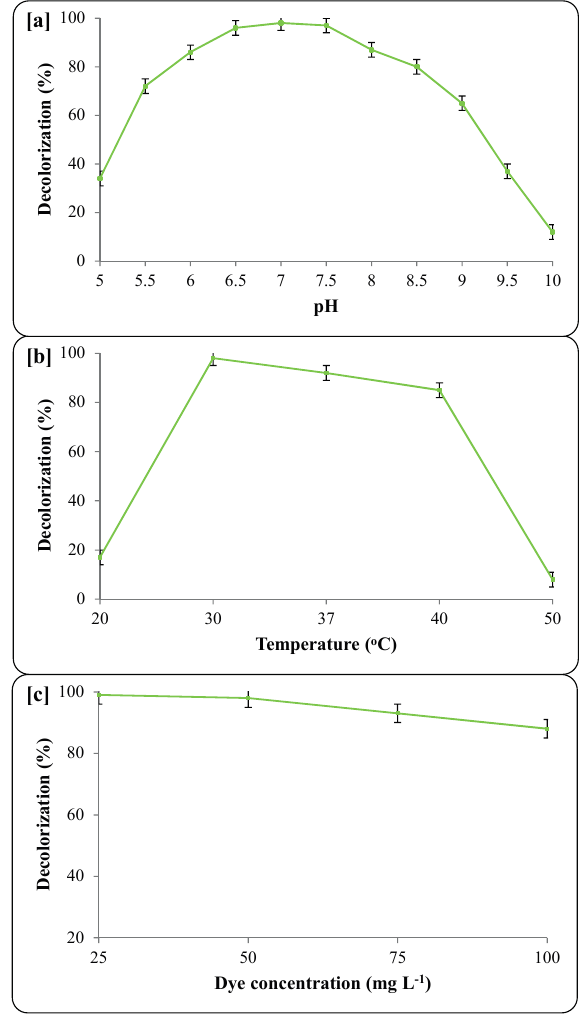
Figure 5. Effect of environmental parameters on decolorization of Trypan Blue (50 mg·L − 1 ) by microbial consortium; ( a ) initial pH of pre-enriched culture medium, ( b ) incubation temperature, ( c ) various dye concentration. Decolorization was measured after 24 h of incubation. Data points represents the mean of three independent replicates, standard error of mean is indicated by error